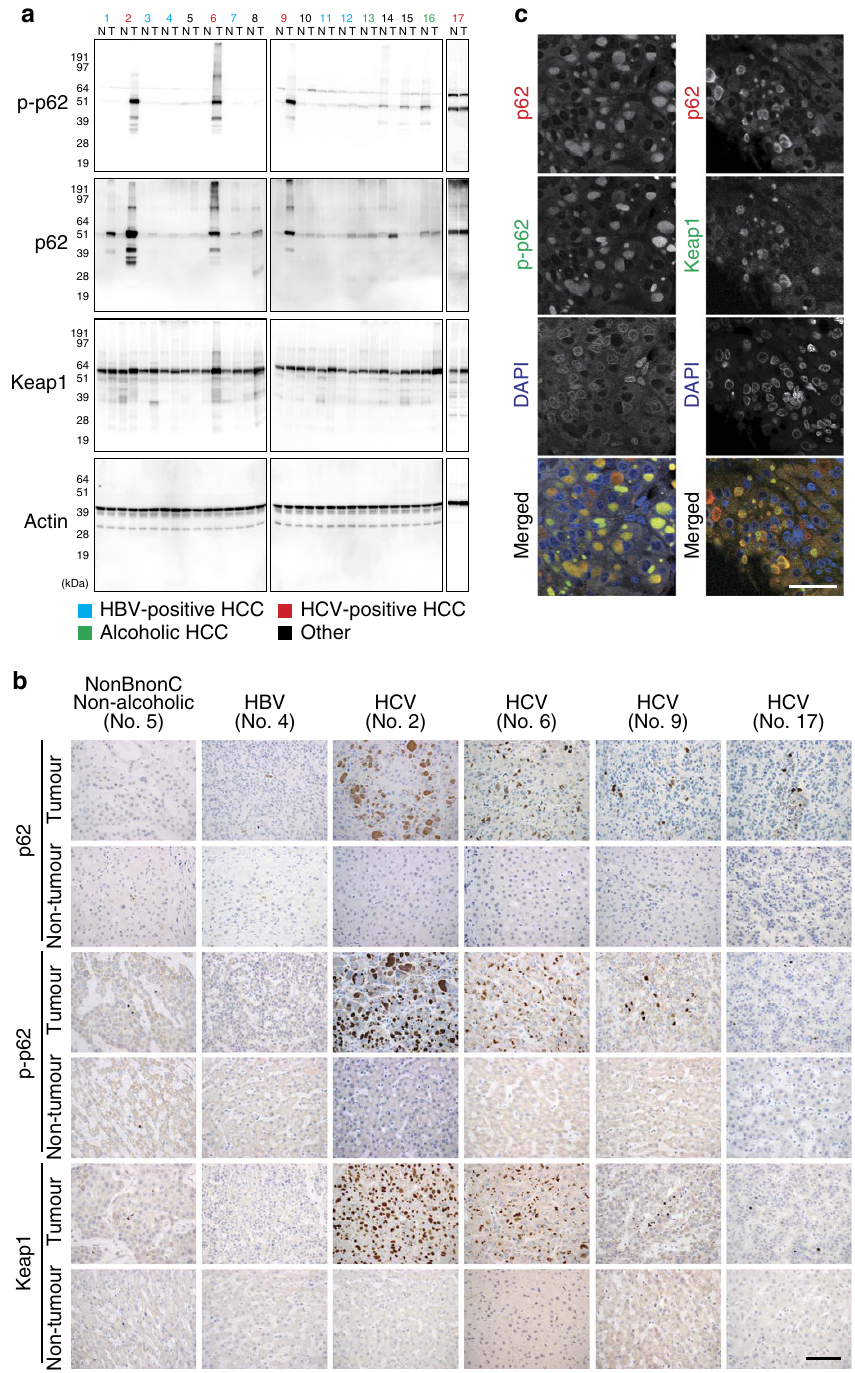
Figure 8 | Dynamics of S349-phosphorylated p62 in human HCC. ( a ) Immunoblot analysis of human HCC lysates with the indicated antibodies. Types of HCC are indicated; the other patients are four cases of non-alcoholic HCC (No. 5, 8, 10 and 15), and one case of combined hepatocellular and cholangiocarcinoma (No. 14). N: non-tumour region; T: tumour region. ( b ) Immunohistochemical images. Paraffin sections of indicated human HCC patients were stained with anti-p62, anti-S349-phosphorylated p62 or anti-Keap1 antibody. Scale bar, 100 m m. ( c ) Double immunofluorescence microscopy. Three cases of HCV-positive human HCC containing typical aggregates were double-immunostained with anti-p62 and anti-S349-phosphorylated p62 (left) or anti-p62 and Keap1 (right) antibodies. Merged images of p62 (red) and phosphorylated p62 (green) or p62 (red) and Keap1 (green) are shown on the right. Scale bar, 50 m